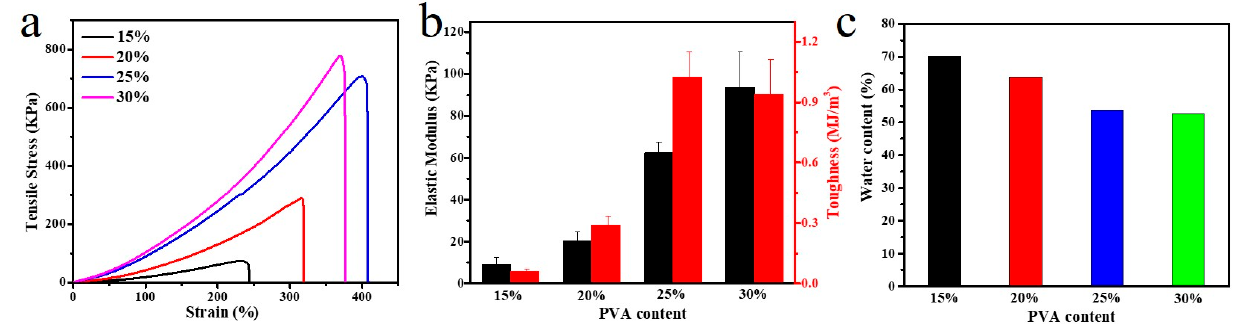
Figure 5. Mechanical properties of hydrogels. ( a ) Tensile stress–strain curves of PVA/SA/NaCl hydrogels with a different PVA content and ( b ) the calculated elastic modulus and toughness; each test was performed by pulling an un-notched sample to rupture. ( c ) Water content of PVA/SA/NaCl hydrogels with a different PVA content. Error bars indicate the standard deviation, and n = 3.